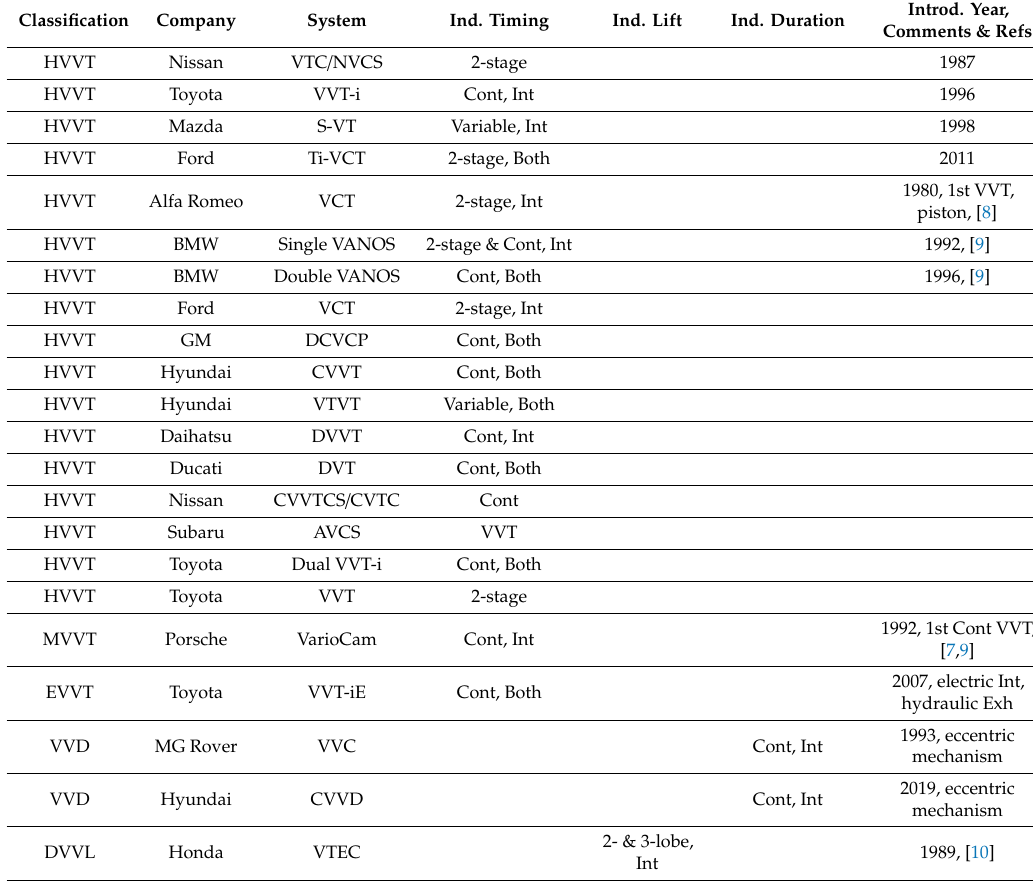
Table 1. Major cam-based valve actuation systems in production